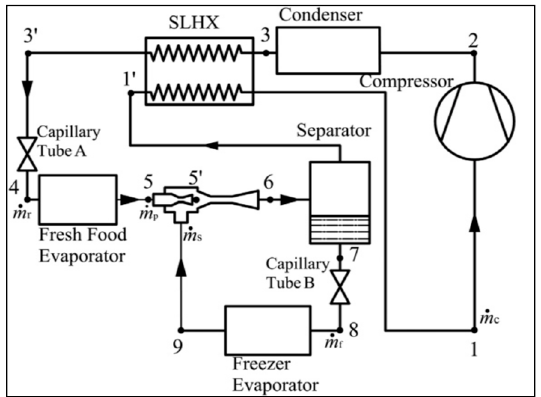
Figure 14. Ejector application in domestic refrigeration and freezing [180].